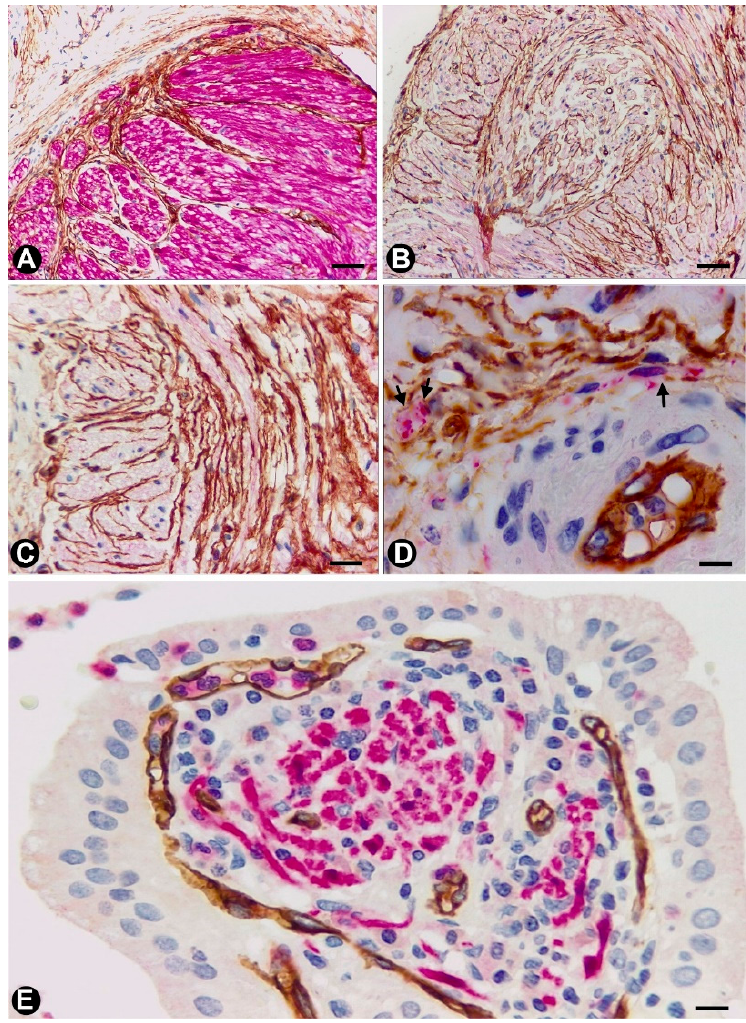
Figure 5. TCs in the neurogenic hyperplasia of gallbladder. ( A ) Presence of TCs/CD34+SCs (brown) around and within a thick nerve in the gallbladder wall. Schwann cells expressing S-100 (red) are seen. ( B , C ) TCs/CD34+SCs (brown) between fascicles and independent nerve fibres arranged in different directions within the nerves. ( D ) Nerve fibres (expressing neurofilaments, red) between TCs/CD34+SCs (brown) in the blood vessel adventitia. ( E) Nerve fibres in the chorion of the mucosa. The absence of TCs/CD34+SCs is noted. A and E: Sections double-immunostained with anti-CD34 (brown) and anti-S100 (red). B and C: Sections immunostained with anti-CD34 (brown). D: Section double-immunostained with anti-CD34 (brown) and anti-neurofilaments (red). Bar: A, C, 80 µm; B, 100 µm; D, 20 µm; F, 30 µm.